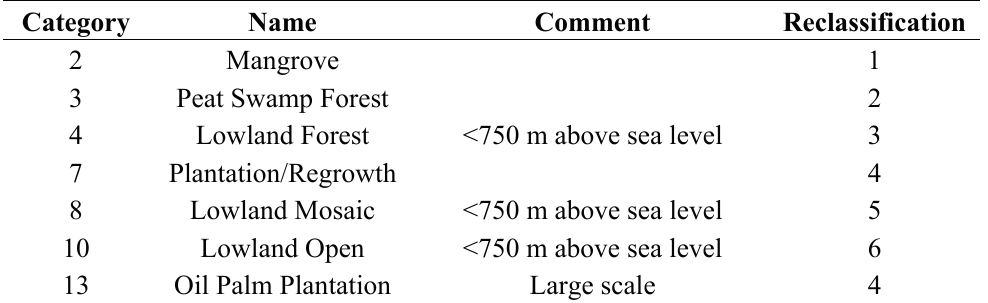
Table 2. Land cover classification from CRISP land cover indicating categories which occur in the area of interest. Category 13, Oil Palm Plantation, does not appear on the land cover map for 2000 and was reclassified as Plantation/Regrowth in the 2010 land cover